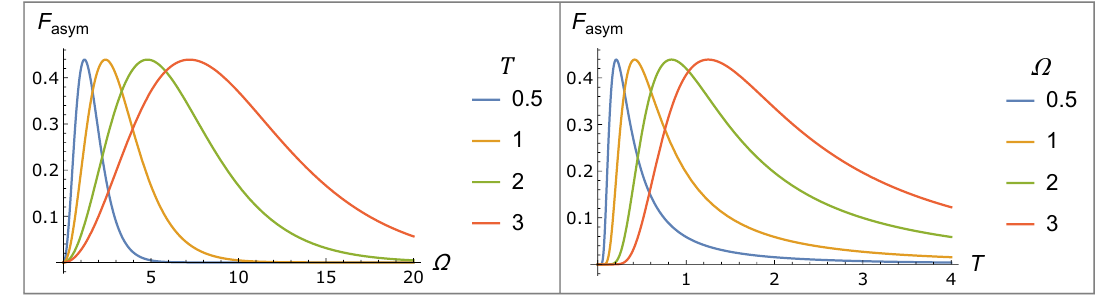
Figure 3 . The asymptotic Fisher information as a function of energy gap Ω (left) and temperature T (right). Note that there is always one Ω ( T ) that maximizes the asymptotic Fisher information for fixed T (fixed Ω